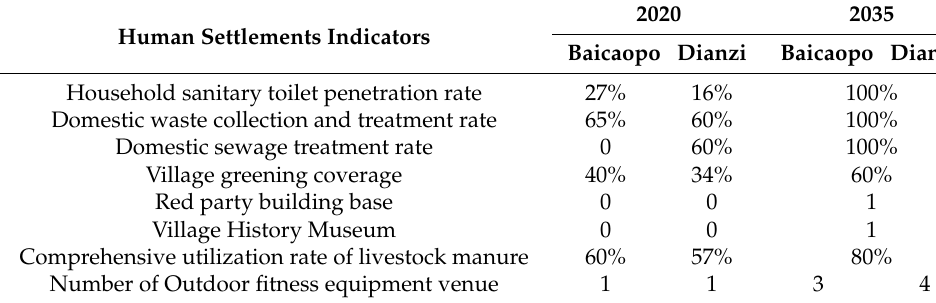
Figure 10. Pictures of a residential area under the village planning in Baicaopo Village. Table 2. Human settlements index table in Baicaopo and Dianzi villages.